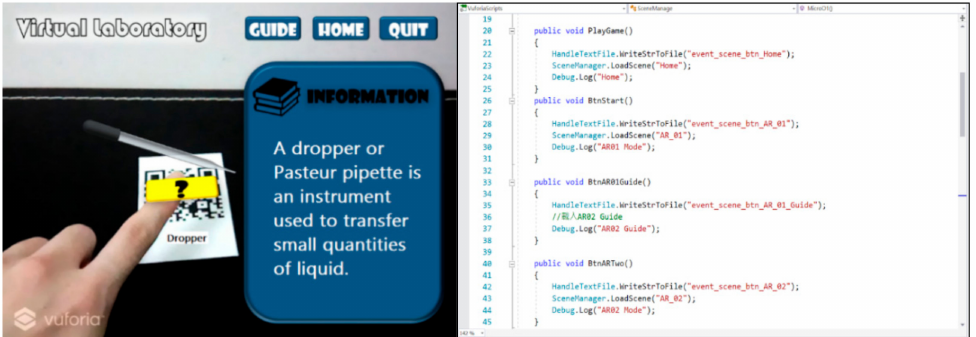
Figure 6. The AR card showing the 3D model and information of a